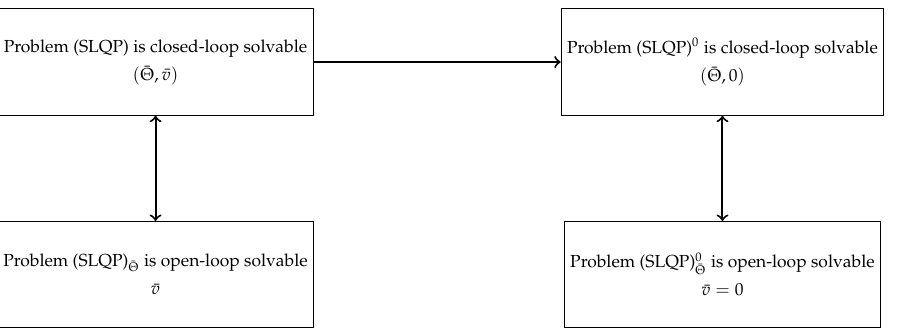
Figure 1. The relationship among